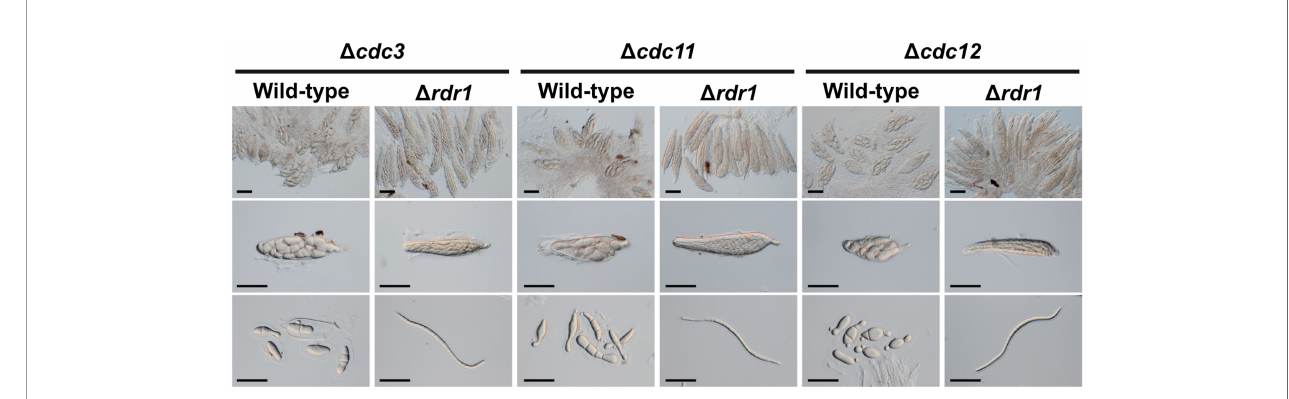
FIGURE 5 | Asci and ascospores from crosses between the D rdr1 strain and null mutants of the CDC3 , CDC11 , and CDC12 genes. The D rdr1 strain was crossed with the null mutants of septins. After 4 weeks, resulting pseudothecia were harvested and dissected to observe the asci and ascospores. Bars : 50